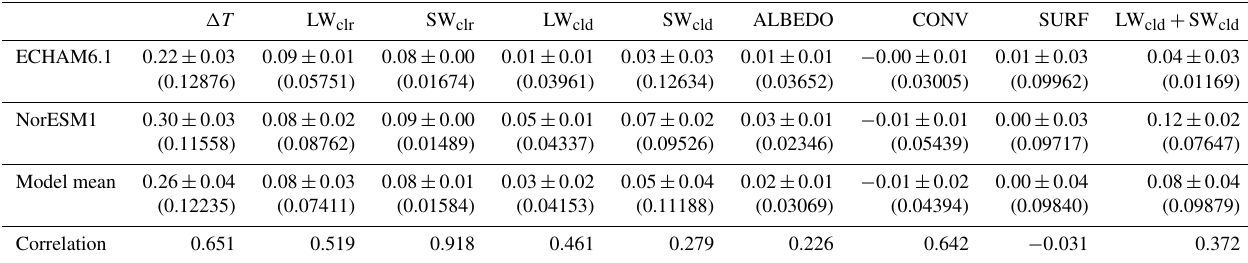
Table A1. Upper rows for each model and model mean: yearly global-mean values in kelvins, with errors on the means given with a 95% confidence interval. Error on the model mean is given as a pooled sample standard error on the mean. Values in brackets show the standard deviations in yearly mean values (pooled standard deviations for model mean). The bottom row: spatial correlation between NorESM1 and